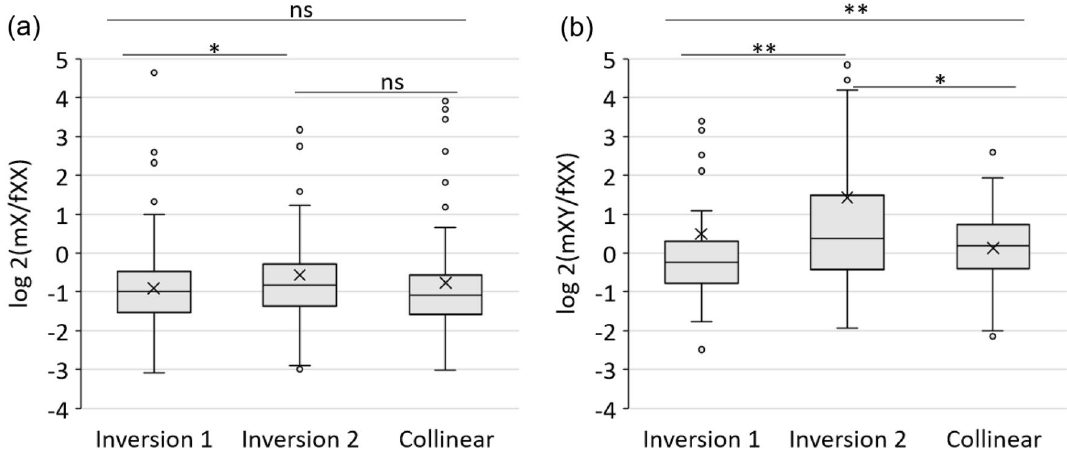
Figure 3. Boxplot of the log 2 transformed expression ratios of mX/fXX ( a ) and mXY/fXX ( b ) of genes on two different evolutionary strata in papaya male samples. Mann–Whitney’ test was used for statistics analysis. ** p < 0.01; * p < 0.05, ns: no significant. The line halfway the plot marks the median for each box. The X in the box represents the mean for each box.